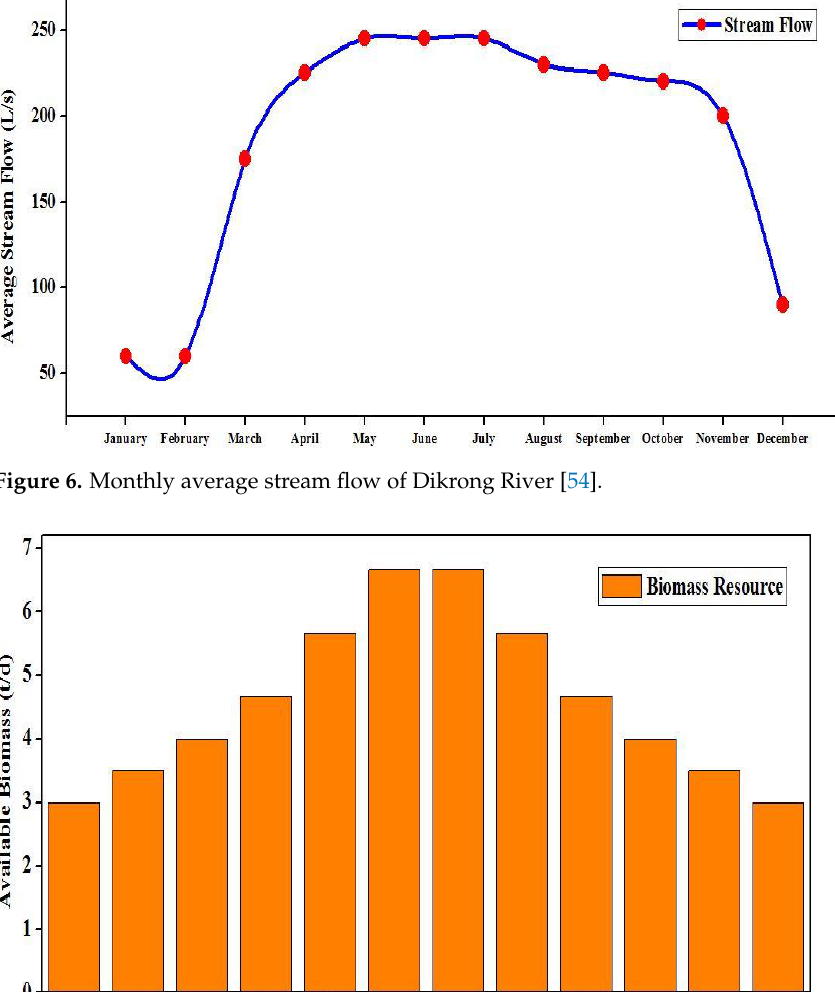
Figure 6. Monthly average stream flow of Dikrong River [54].